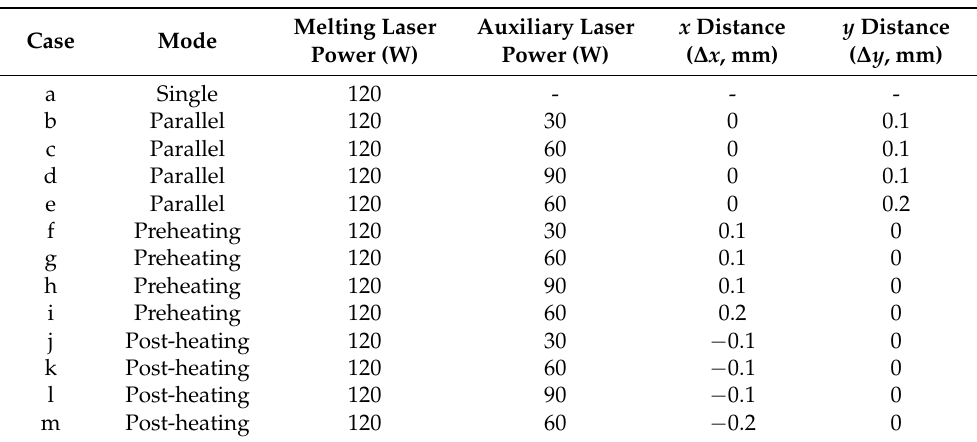
Table 2. Process parameters applied for the single laser beam and different strategies of dual-laser PBF-LB